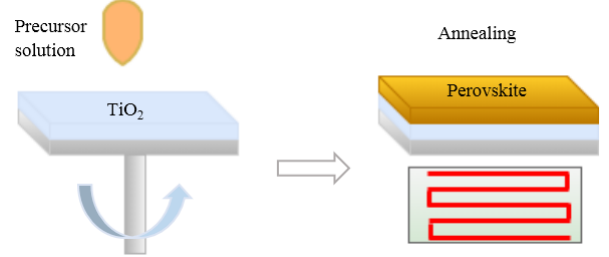
Figure 2: One step spin-coating method